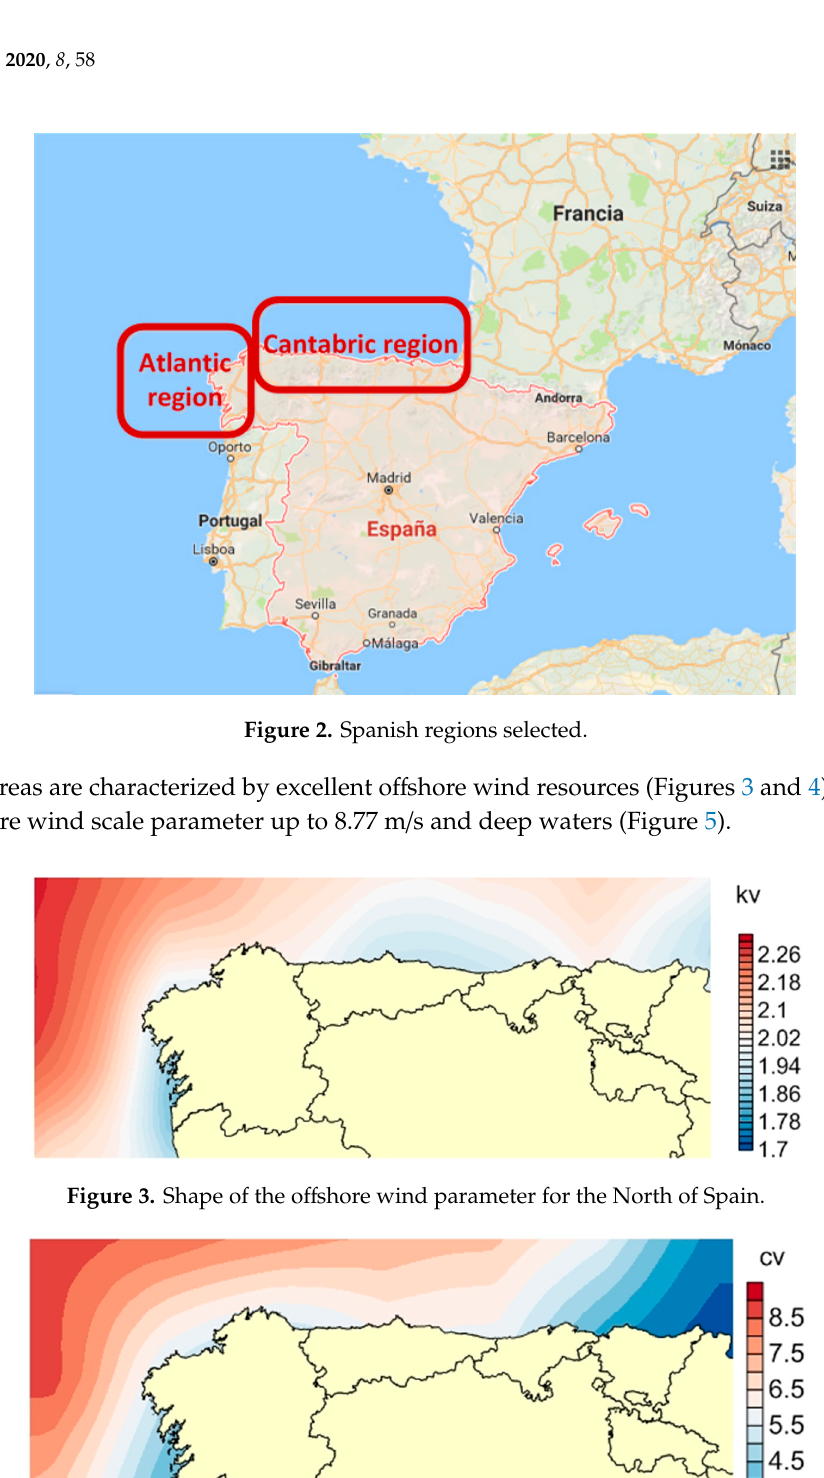
Figure 5. Bathymetry of the North of Spain. The farm is composed of twenty-one floating offshore wind generators of 5.075 MW of power, a life cycle of 20 years, and the size of the grid is 16 km × 33 km. Three different floating offshore wind structures were considered: semisubmersible TriFloater [49], MIT (Massachusetts Institute of Technology) Tensioned Leg Platform (TLP) [50], and spar OC3- Hywind [51], whose dimensions are shown in Table 1 and Figure 6. These structures were selected because they are the most representative of the floating offshore wind and the platforms with the most data available.